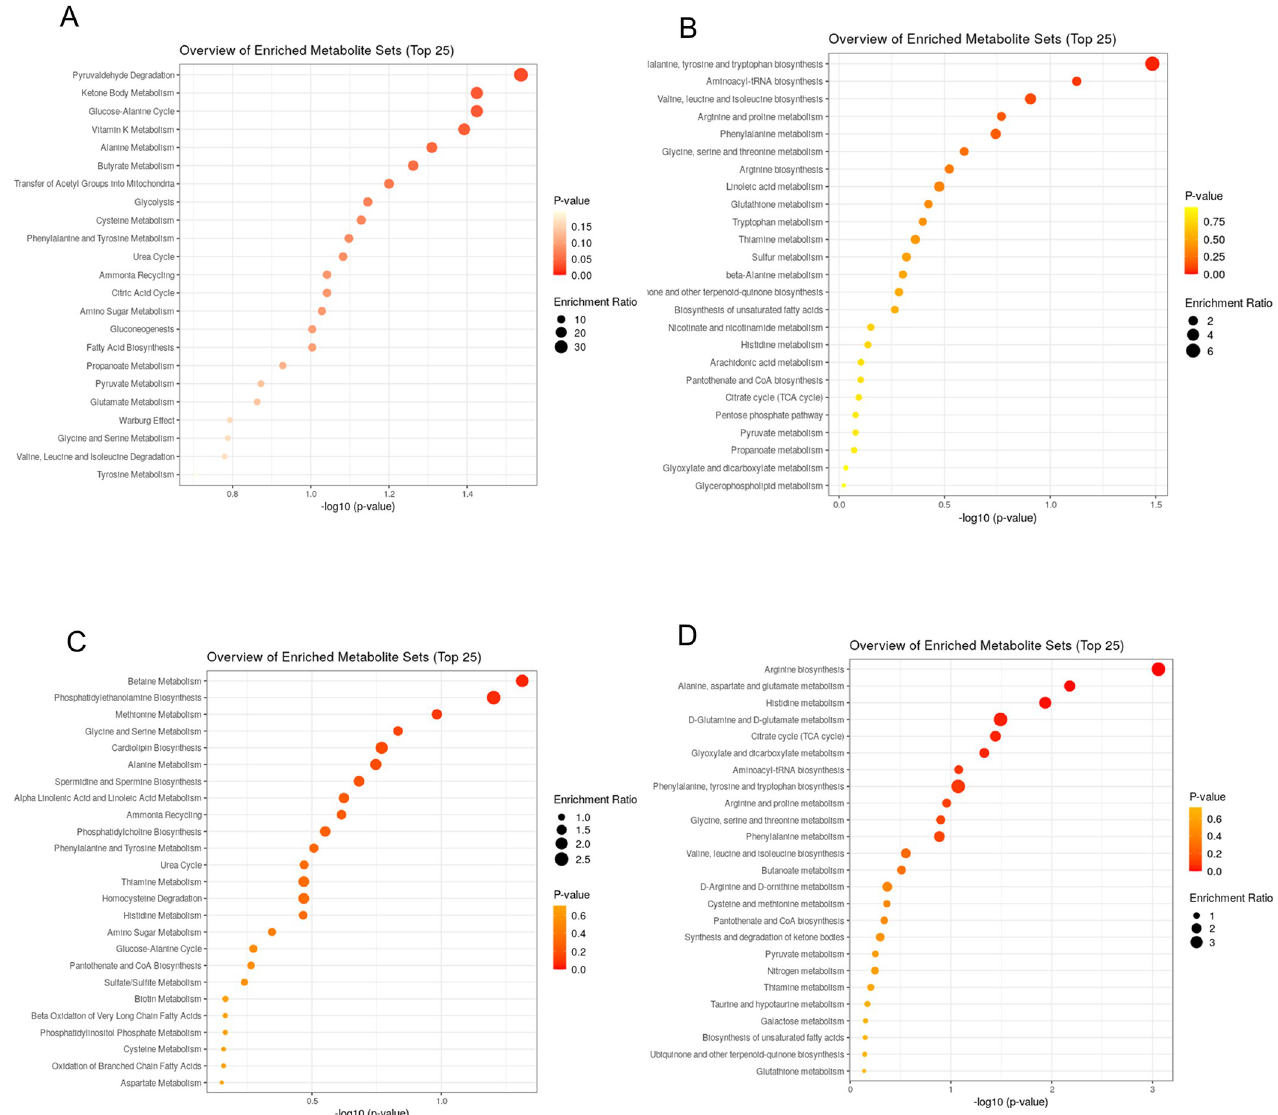
Fig 3. Metabolomics pathway analyses. (A) Small molecule pathway database (SMPDB) metabolic pathway analysis for filtered annotated compounds in both C18 modes ranked by P-value. (B) Kyoto Encyclopedia of Genes and Genomes (KEGG) metabolic pathway analysis for filtered annotated compounds in both C18 modes ranked by P-value. (C) Small molecule pathway database (SMPDB) metabolic pathway analysis for filtered annotated compounds in both HILIC modes ranked by P-value. (D) Kyoto Encyclopedia of Genes and Genomes (KEGG) metabolic pathway analysis for filtered annotated compounds in both HILIC modes ranked by